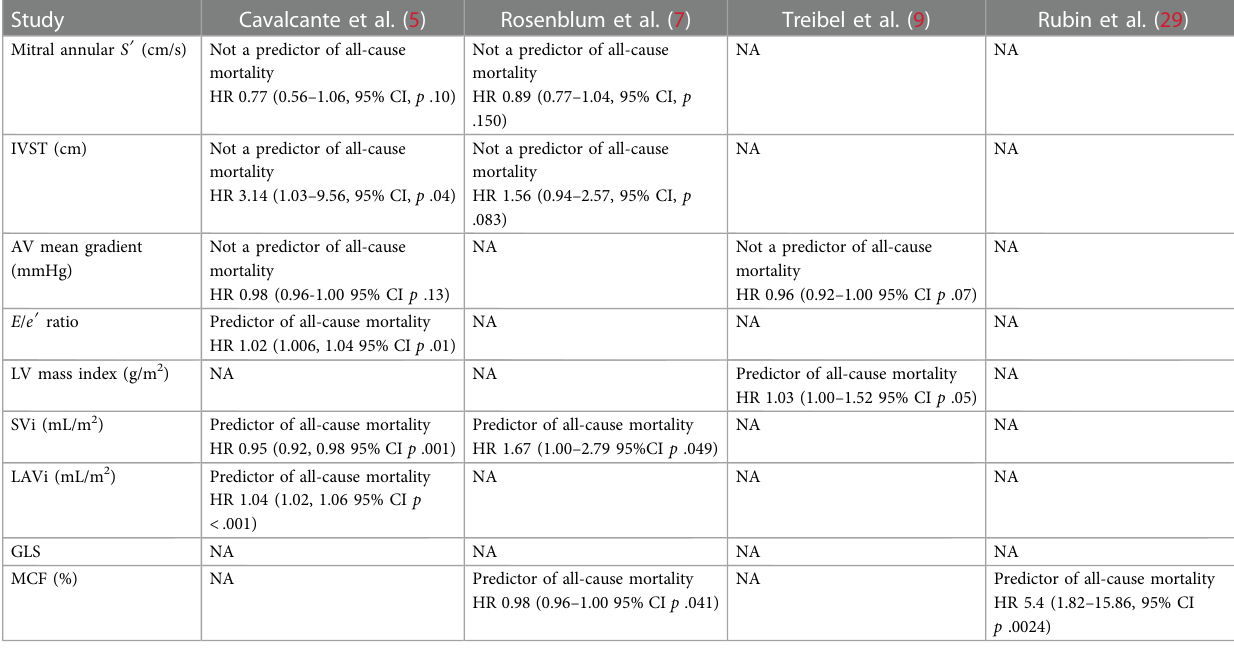
TABLE 2 Echocardiographic predictors of all-cause mortality in patients with aortic stenosis and ATTRwt-CA. Study Cavalcante et al. (5) Rosenblum et al. (7) Treibel et al. (9) Rubin et al. (29) Mitral annular S ′ (cm/s) Not a predictor of all-cause